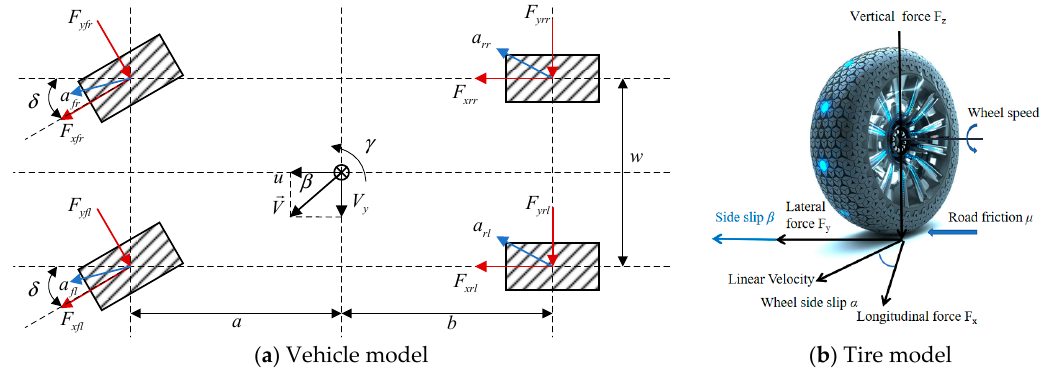
Figure 1. The 4WID Vehicle Dynamics Model.